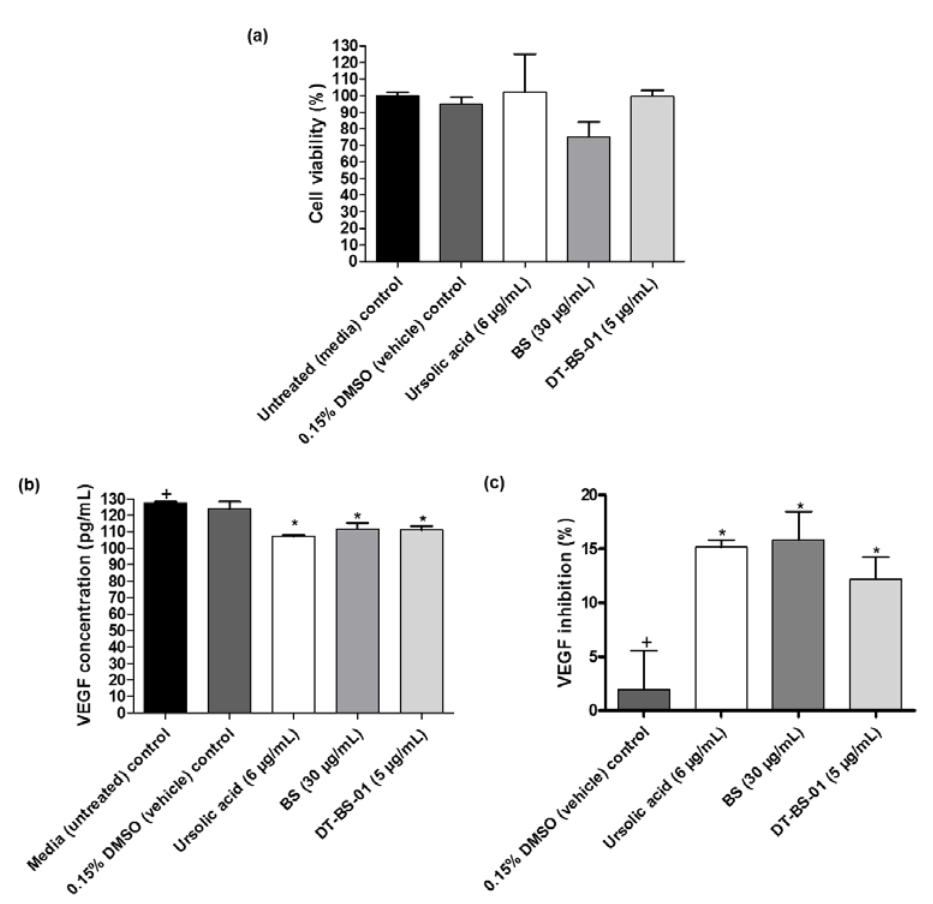
Figure 7. Quantification of VEGF in HaCat cells after treatment with BS (30 µ g/mL) and DT-BS-01 (5 µ g/mL) for 6 h. Controls included the positive control, ursolic acid (6 µ g/mL), DMSO (0.15%) vehicle control and cells grown in medium (untreated). ( a ) Percentage cell viability, ( b ) vascular endothelial growth factor (VEGF) concentration (pg/mL) and ( c ) percentage VEGF inhibition. Data was expressed as mean ± SEM ( n = 3). * p < 0.05 indicates statistical significance when compared to the control (+). Statistical analysis was done using one-way ANOVA followed by Dunnett’s Multiple Comparison